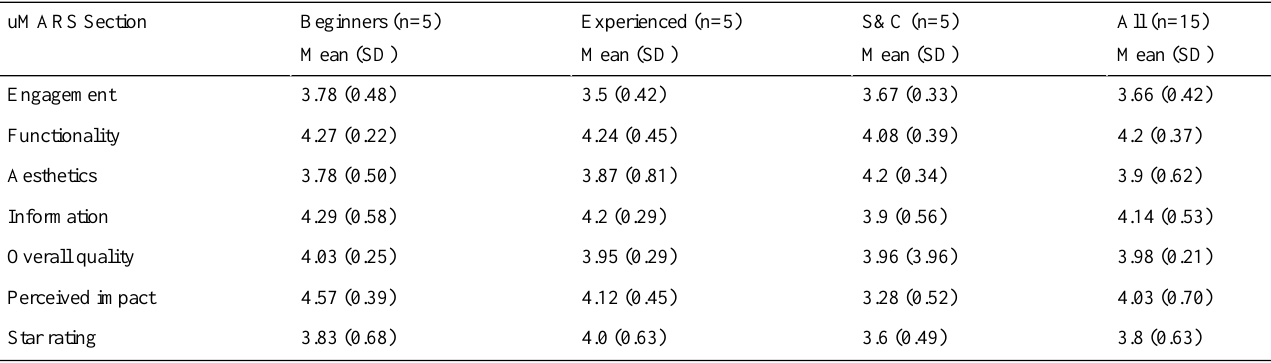
Table 1. Results from user version of the Mobile Application Rating Scale (uMARS) survey for beginner gym-goers, experienced gym-goers, and strength and conditioning (S&C) coaches. Overall quality is computed as described in the study by Stoyanov et al.